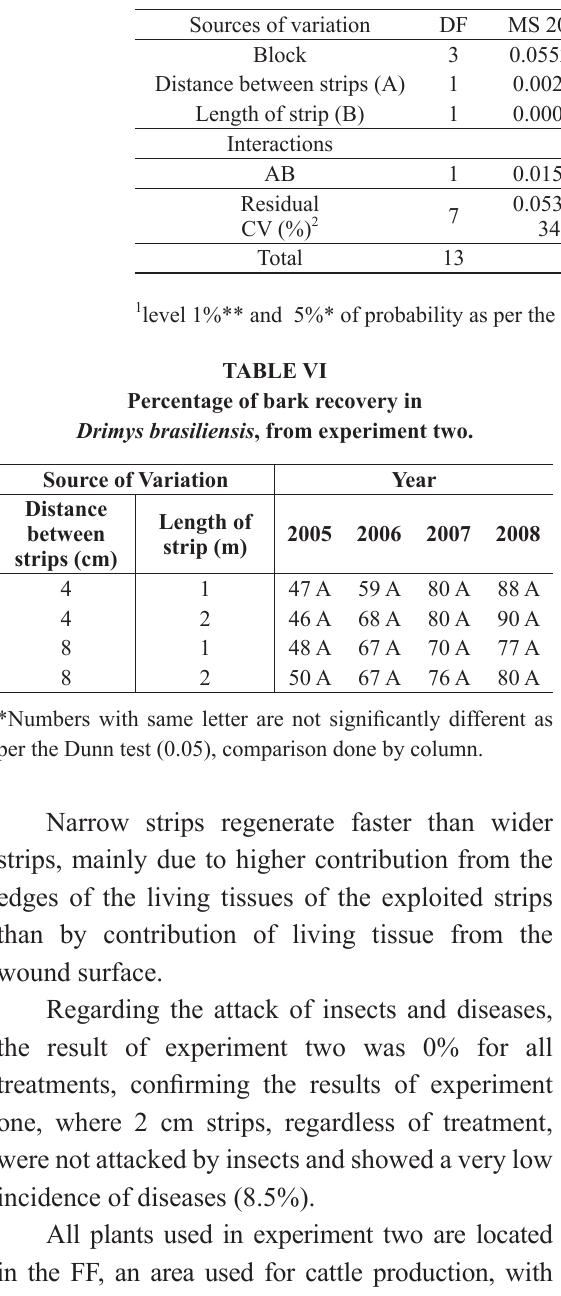
ANOVA test results for percentage of bark recovery in Drimys brasiliensis , in the years 2005, 2006, 2007 and 2008, from experiment two.